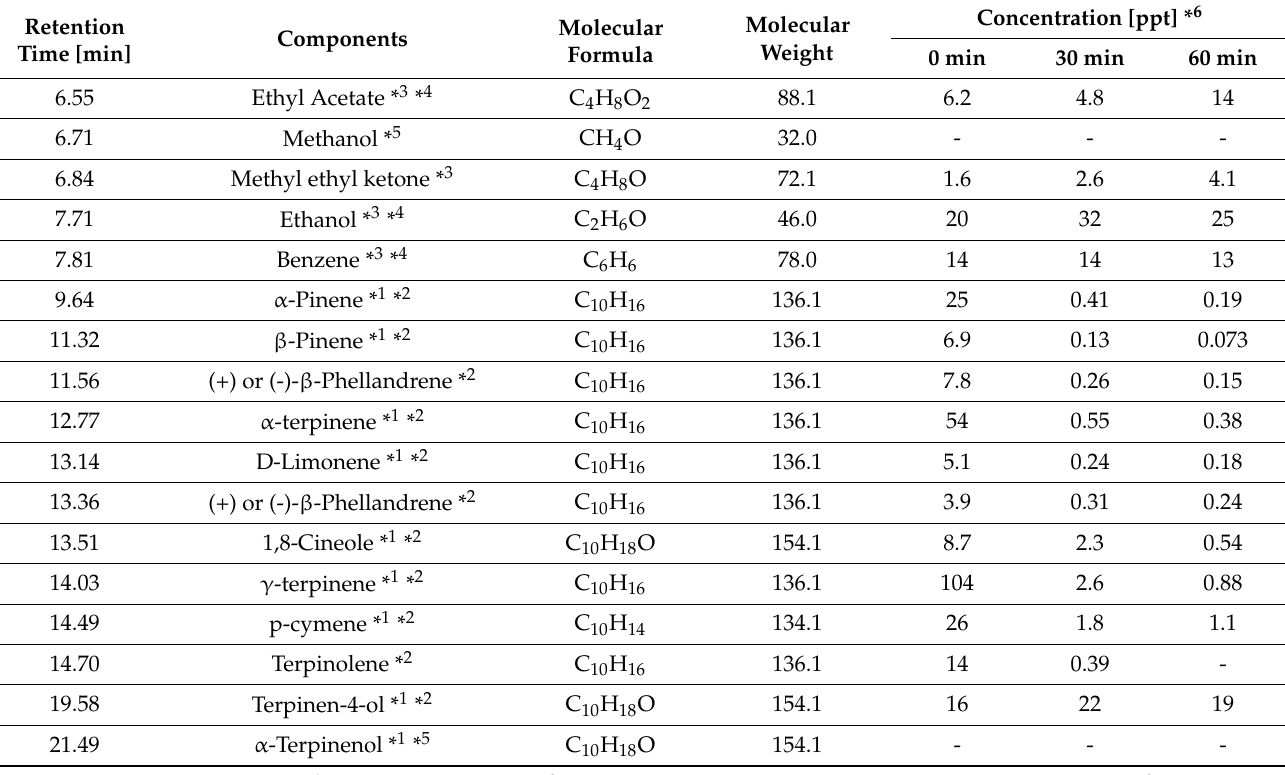
Table 4. The concentration of each component from room air including diffused tea tree oil.